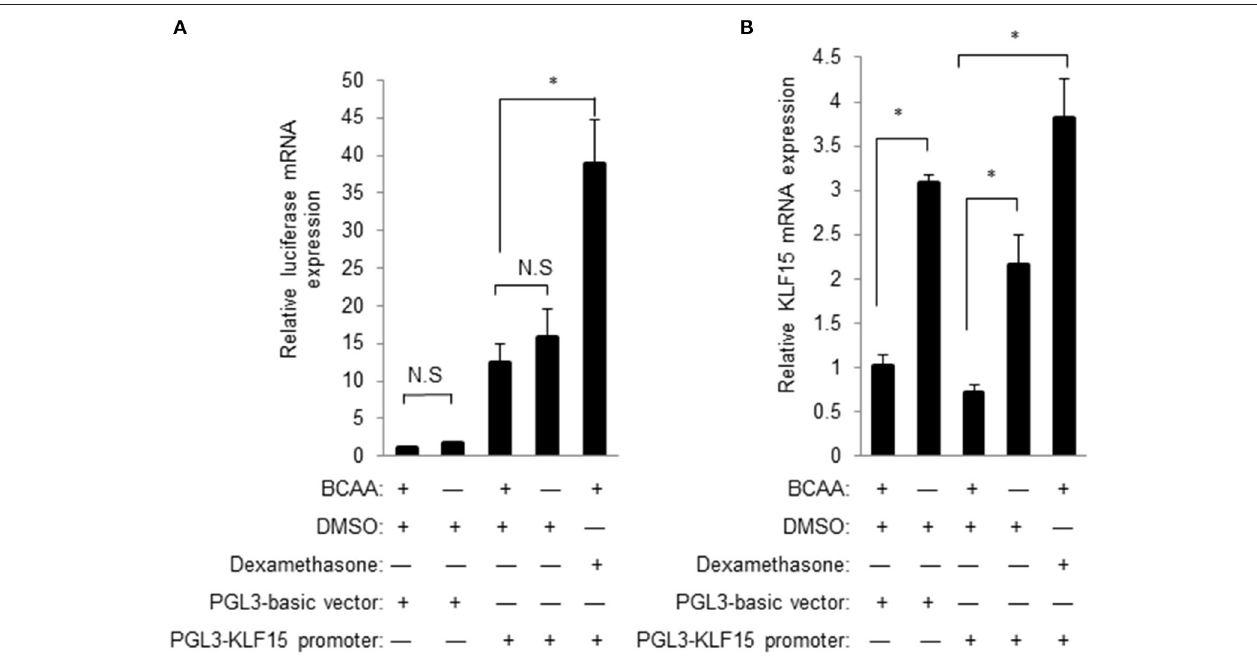
FIGURE 6 | BCAA does not directly affect KLF15 promoter activity. Quantitative PCR was performed to measure the mRNA level of luciferase (A) or KLF15 (B) in cells transfected with empty PGL3-basic or KLF15-promoter-driving luciferase constructs and treated with BCAA starvation ( − ) or dexamethasone for 24h. Data are means ± SE for three individual samples. * p <